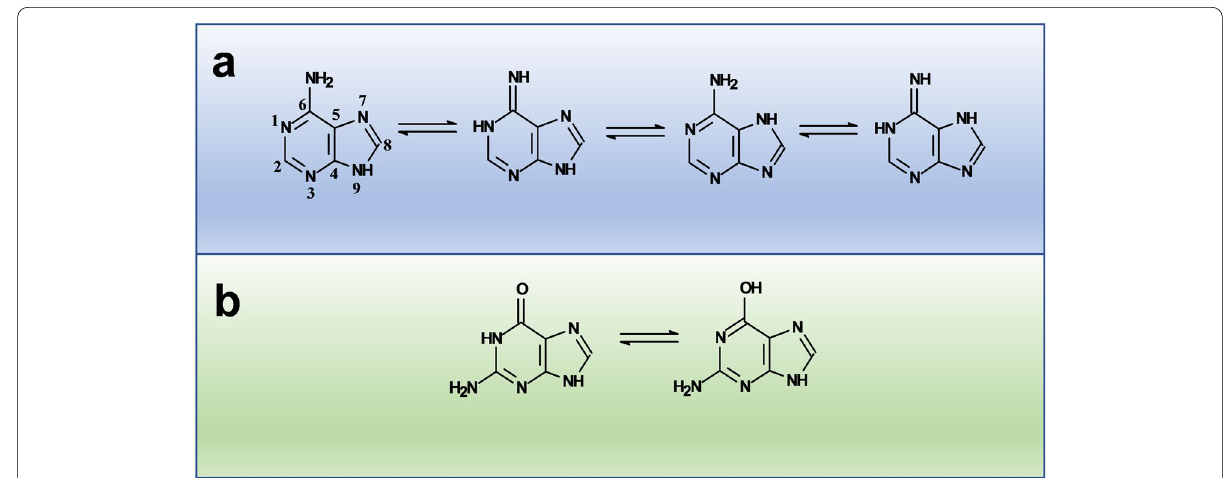
Fig. 3 Adenine and Guanine tautomers in DNA. a) Amino‑imino tautomers of Adenine are the result from the location of the hydrogen atom at N(7) and N(9) (see [2, 6] for stability details). b) Guanine keto‑enol tautomers result when keto (> C protonated and transits to a hydroxyl (‑OH) group. Note that the N(1) changes from amino to imino tautomer as